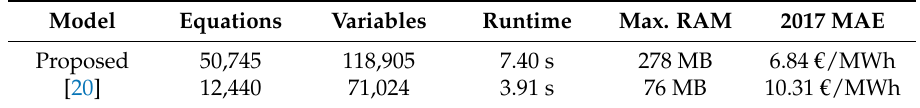
Table 1. Comparison of computational statistics and MAE of the market clearing prices estimated by the fundamental